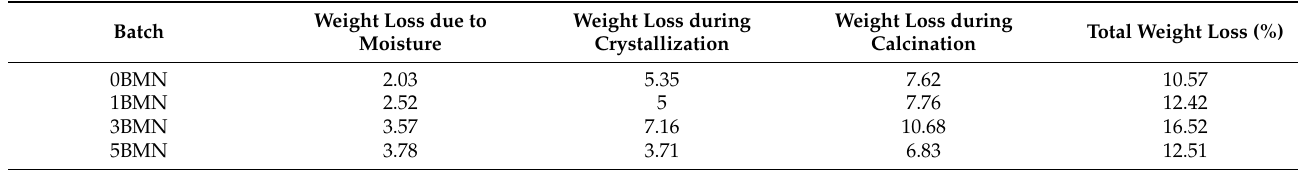
Table 1. Weight loss during TGA of uncalcined